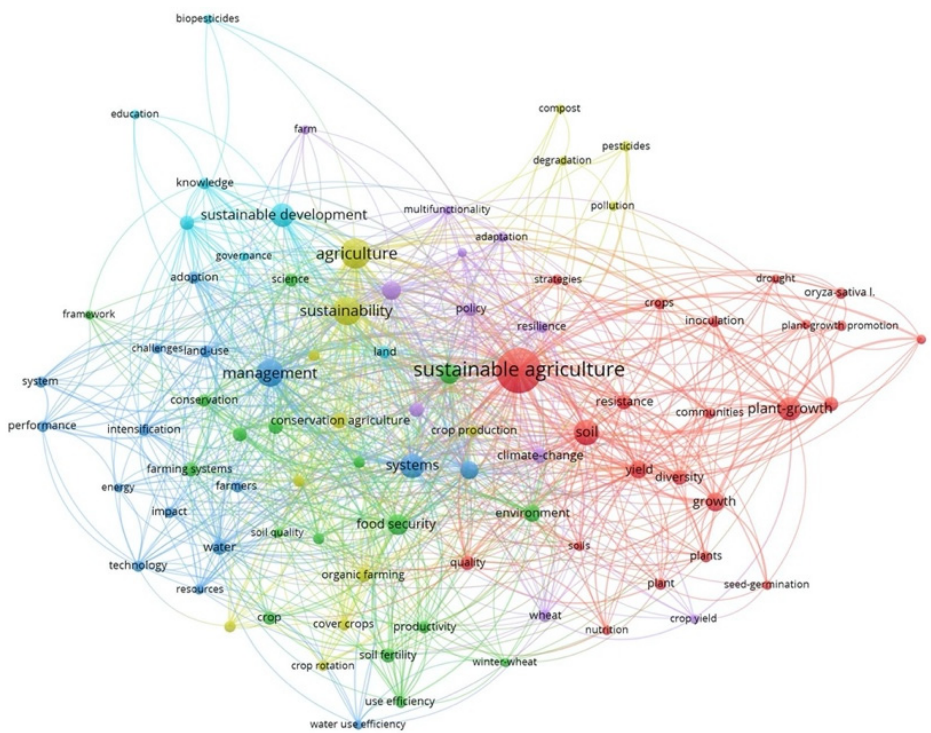
Figure 2. The bibliometric keywords analysis of sustainable agricultural dimension, considering Web of Science (WOS) publications during the years 2017–2022. Source: Elaborated by the authors using VOSviewer software.